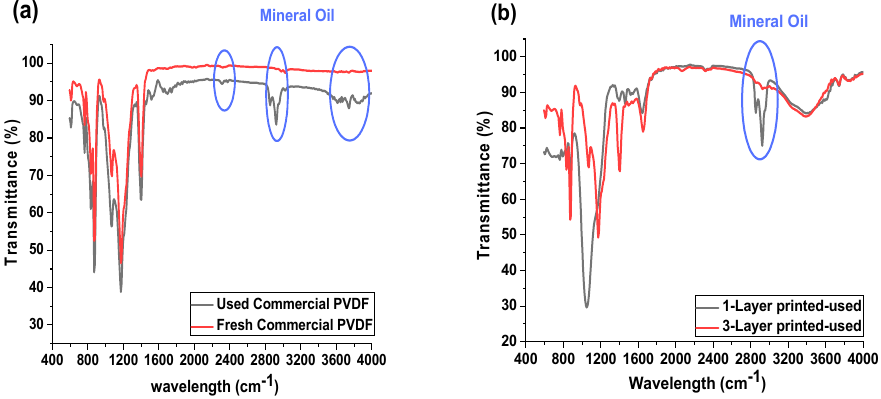
Figure 5. FTIR spectra of the various membranes: ( a ) commercial PVDF membrane before and after oil-fouling test, ( b ) 1-P and 3-P membrane after oil-fouling test.